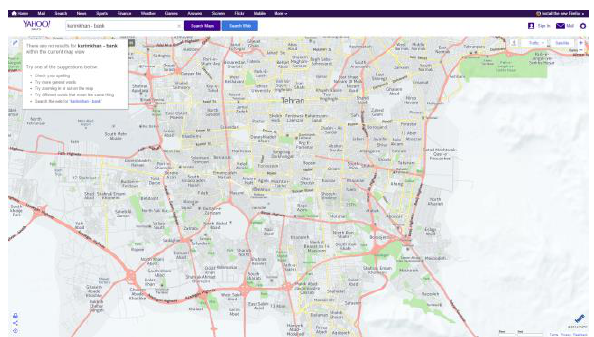
Figure 8. Output of Search Address in Yahoo Maps